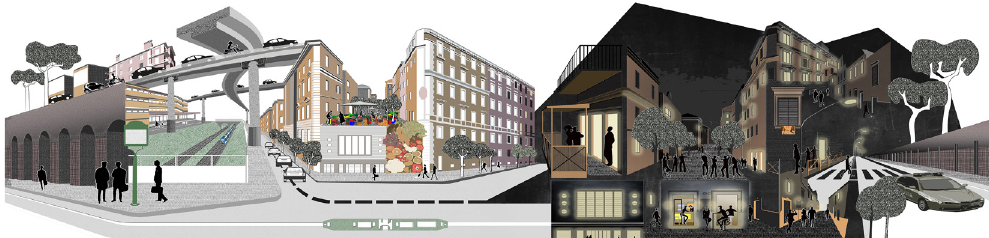
but always preserving its strong identity. The tale winds through the relationships between the inhabitants, large infrastructure, arches of the Roman aqueduct, alleys, and